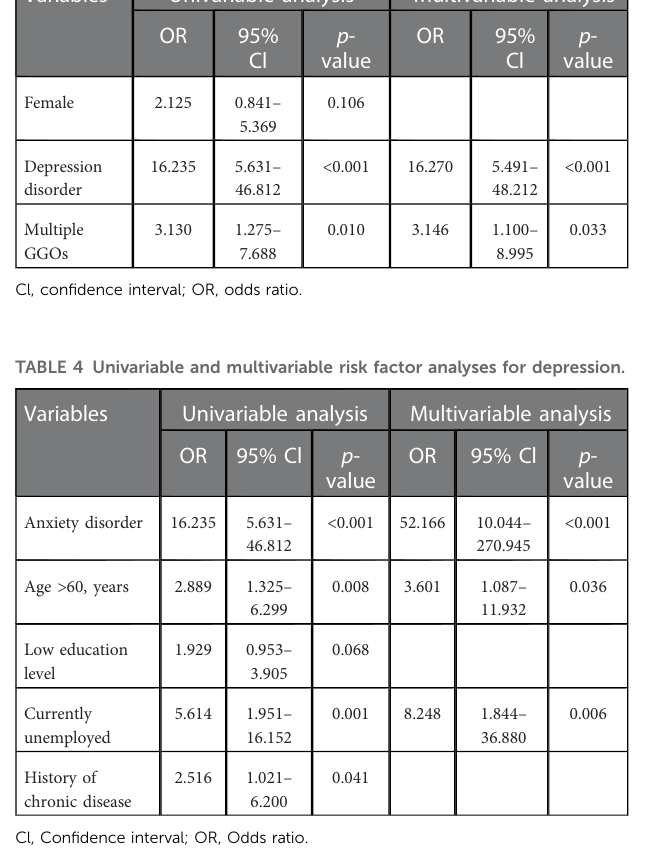
TABLE 3 Univariable and multivariable risk factor analyses for anxiety.